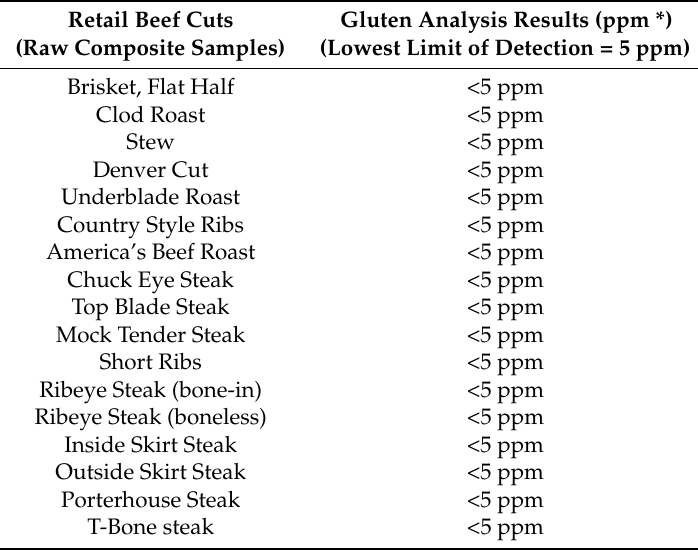
Table 1. Gluten content of composite samples from 17 retail beef